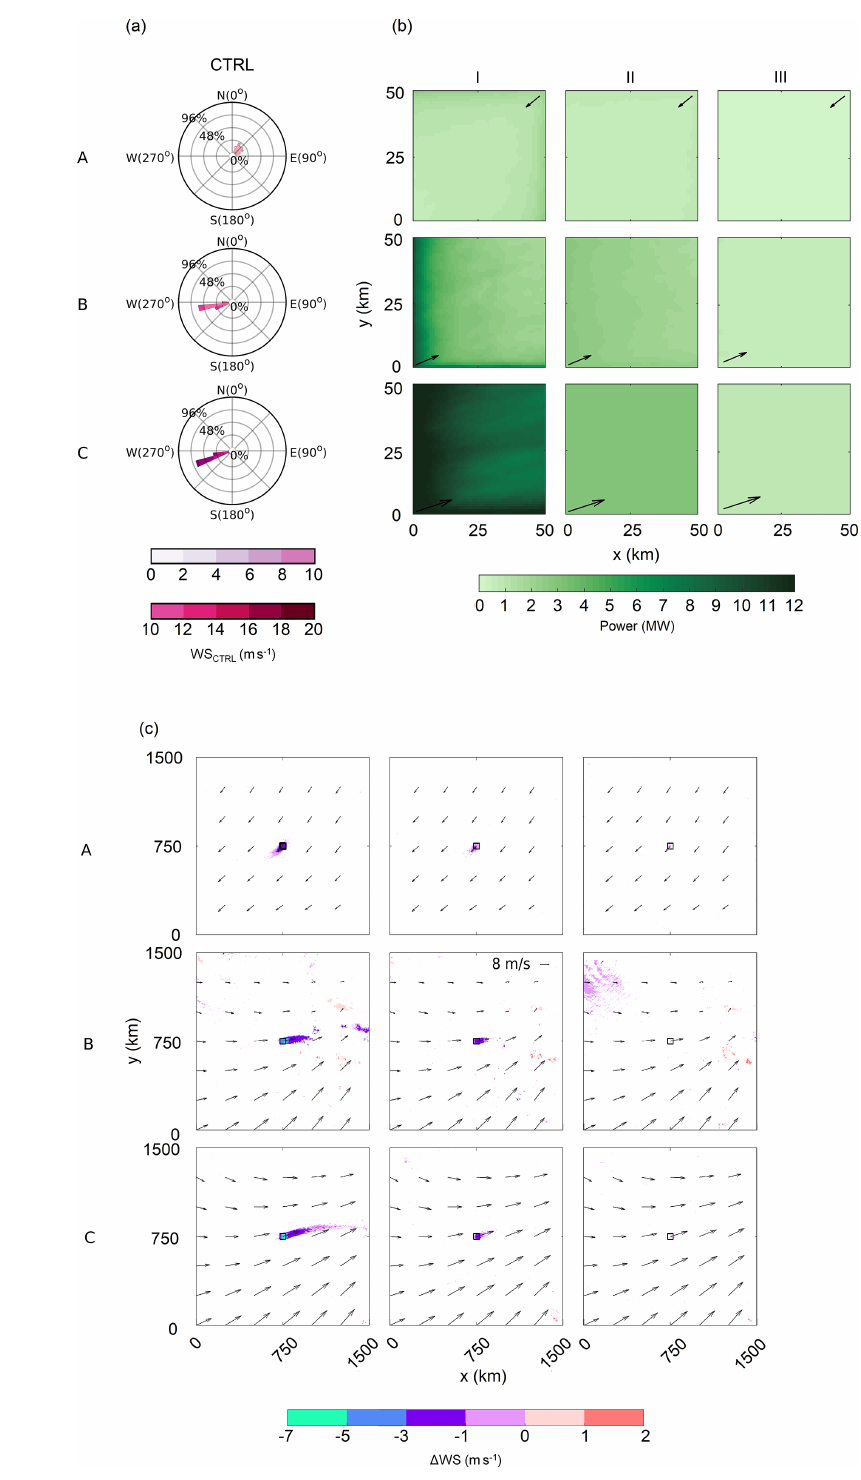
Figure 3. (a) Wind rose diagrams depicting hub-height wind speed (WS; ms − 1 ) over the wind farm area for the CTRL case, (b) av- eraged power (MW) generated in the WF cases, and (c) averaged difference in wind speed ( (cid:49) WS; ms − 1 ) over the rotor depth (28– 140m) (WF − CTRL) for (A) January, (B) June, and (C) July with (I) 0.5km, (II) 1km, and (III) 2km inter-turbine spacings. In (b) , the plot depicts the wind farm only, that is the black square in (c) , and the black arrow shows the prominent wind direction. In (c) , only the statis- tically significant results ( p < 0 . 01) are shown. White colored regions represent areas where the wind speed differences are not statistically significant. The vectors represent the wind in the corresponding CTRL cases; every 250th vector is shown. Wind Energ. Sci., 6, 1089–1106,